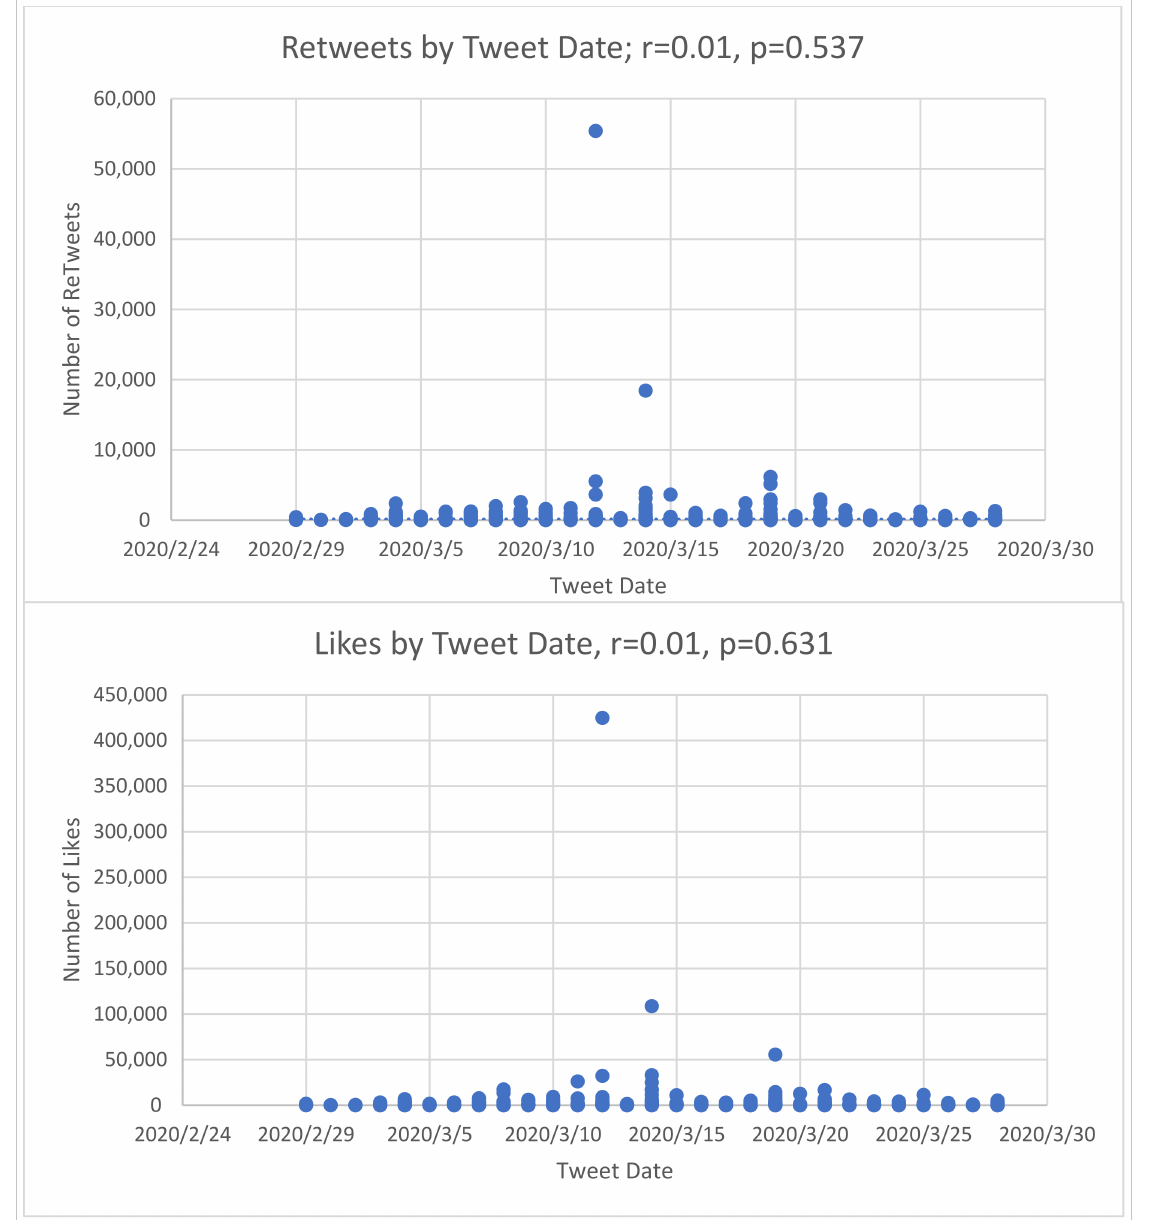
Figure A3. Scatterplots of Retweets and Likes by date of